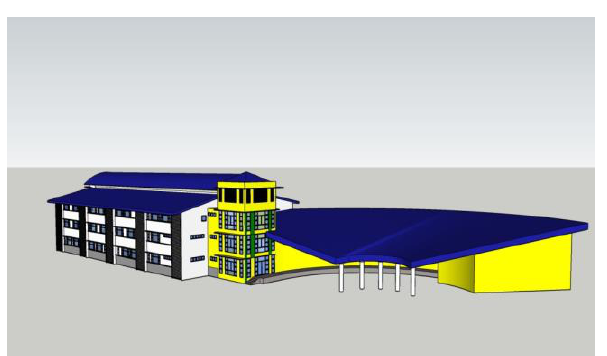
Table 5 Coordinates from TLS and GPS